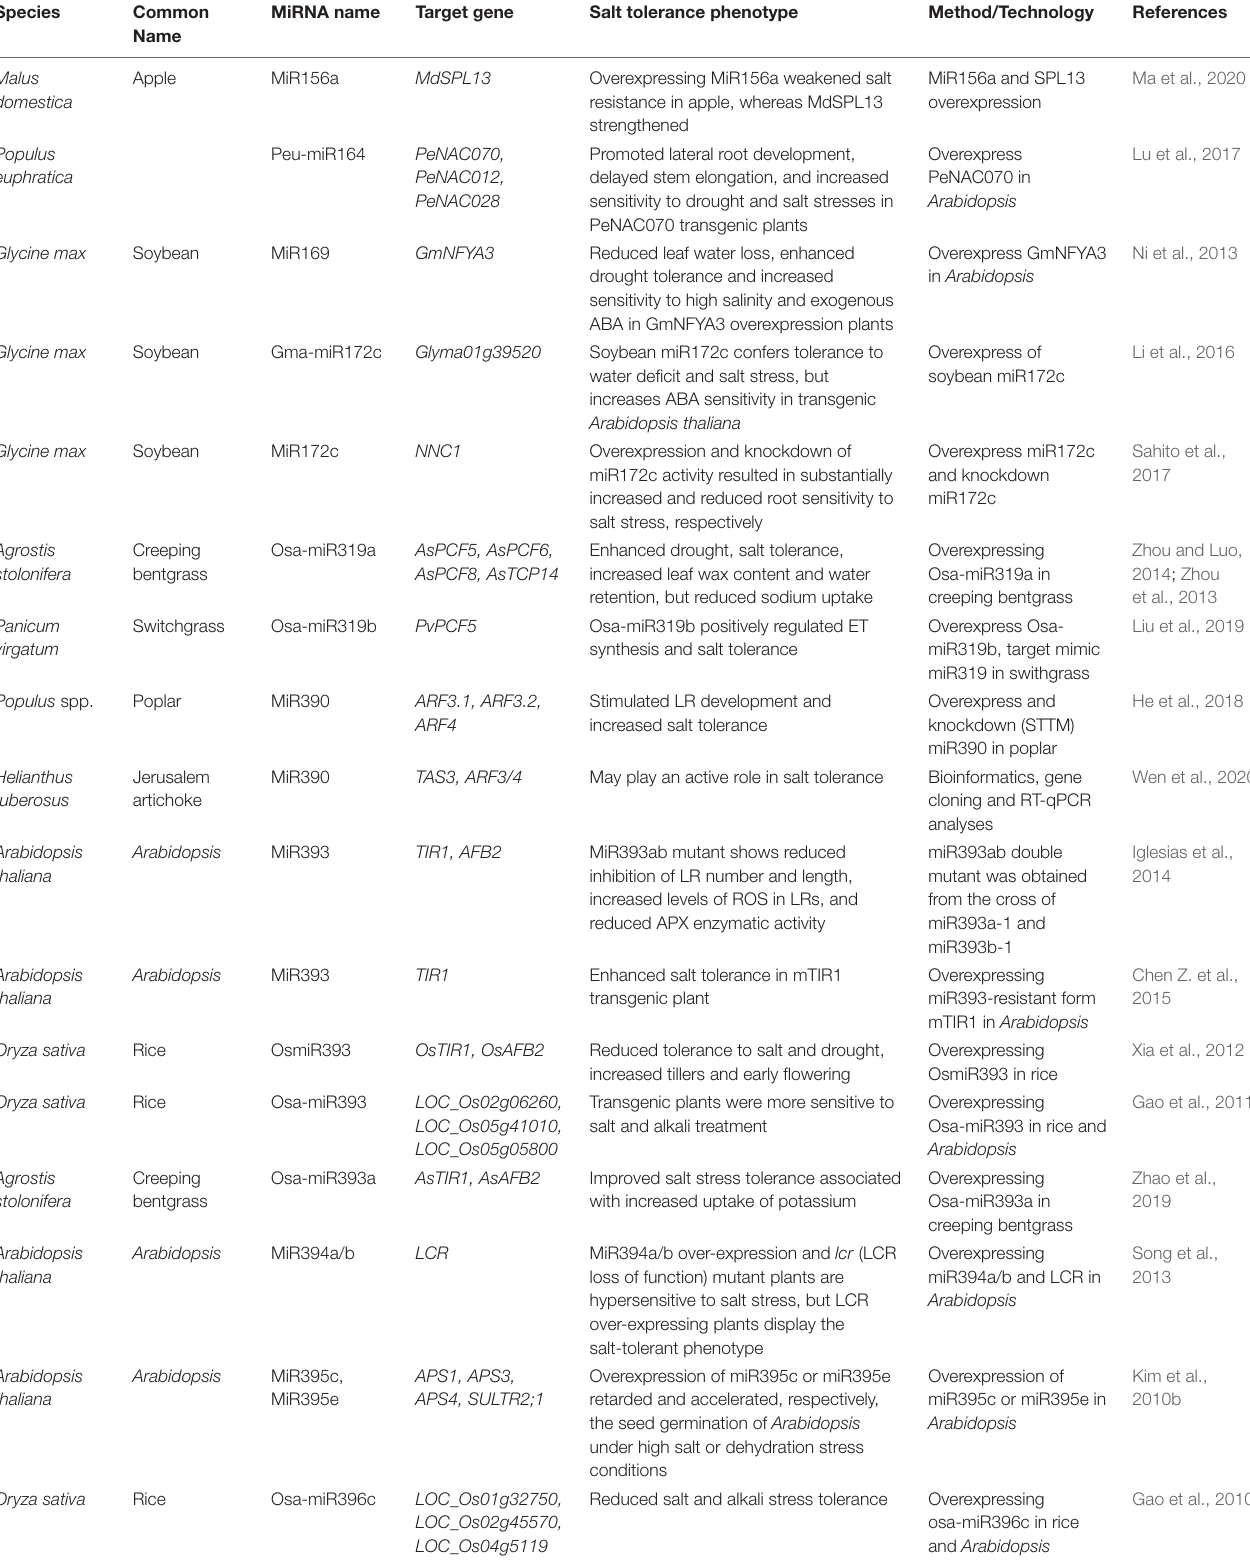
TABLE 3 | The functions of miRNA under salt